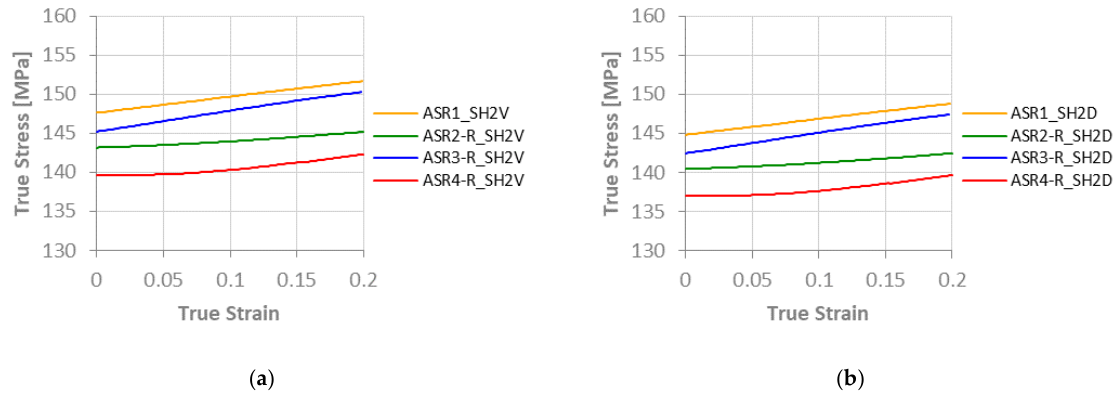
Figure 8. Stress – strain curves of a four-pass asymmetric-reverse rolling sequence, with 20% reduction per pass, considering a shear strain of 0.21 (SH2), only considering texture evolution and no hardening update during simulations using: ( a ) a Voce-type hardening law (V) and ( b ) the DDR model (D). A similar analysis for two-pass rolling sequences, with a 30% reduction per pass, revealed that the DDR model shows higher stress values for the same amount of strain; this is the most evident observation from Figure 9. However, in these sequences, the curves corresponding to the asymmetric rolled-reverse process are almost coincident with the CR and ASR-C curves, while for a 20% reduction passes, the ASR-R curves are noticeably below the other two.